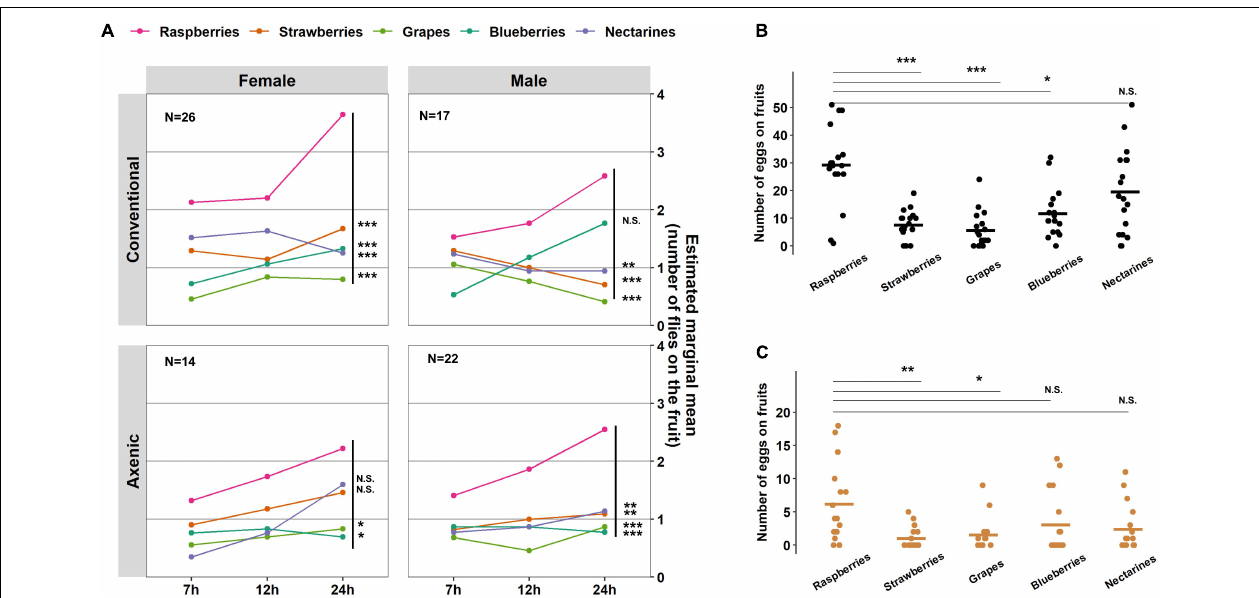
FIGURE 4 | Effects of the microbiome on Drosophila suzukii fruit preferences and oviposition preference. (A) A generalized linear mixed model (GLMM; Poisson) was applied to analyze the number of flies on each fruit in response to time, microbiome status, and sex as fixed effects (and their interactions tested), while arenas and days were accounted for as random effects. The number of eggs laid on each fruit by (B) the conventional fly populations or (C) the axenic fly populations. Statistical significance between raspberries and the other four fruits is indicated with * P < 0.05, ** P < 0.01, *** P < 0.001. NS represents no statistical significance ( P ≥ 0.05). The crossbars represent mean values. N indicates the number of arenas with each containing ten D. suzukii adults. P -values were adjusted by Bonferroni